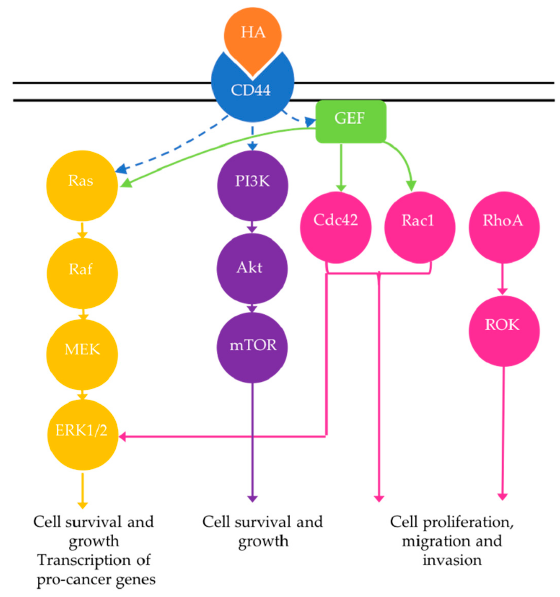
Figure 2. HA interacts with cell surface receptor CD44 which indirectly activates Rho, MAPK and PI3K signaling cascades to promote cell survival, growth, proliferation, migration and invasion and transcription of pro-cancer genes.